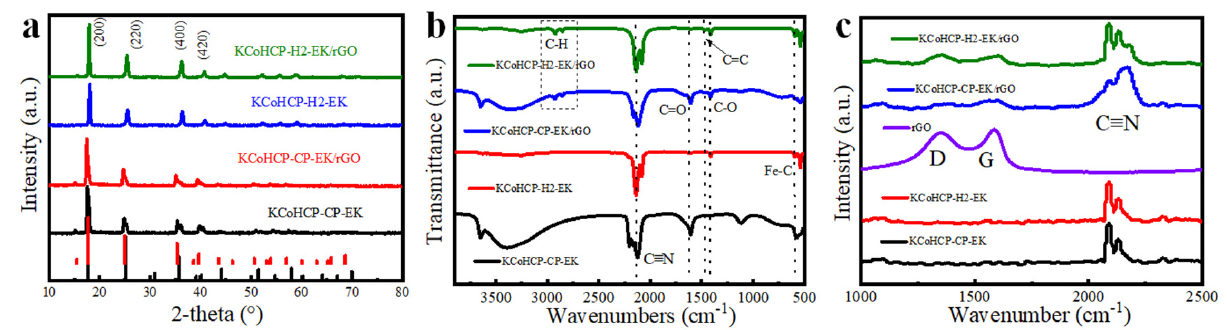
Figure 2. ( a ) XRD images of KCoHCP − H2 − EK/rGO, KCoHCP − H2 − EK, KCoHCP − CP − EK/rGO, KCoHCP − CP − EK; ( b ) FT − IR spectra images of KCoHCP − H2 − EK/rGO, KCoHCP − H2 − EK, KCoHCP − CP − EK/rGO, KCoHCP − CP − EK; ( c ) Raman spectra images of KCoHCP − H2 − EK/rGO, KCoHCP − H2 − EK, KCoHCP − CP − EK/rGO, KCoHCP − CP −